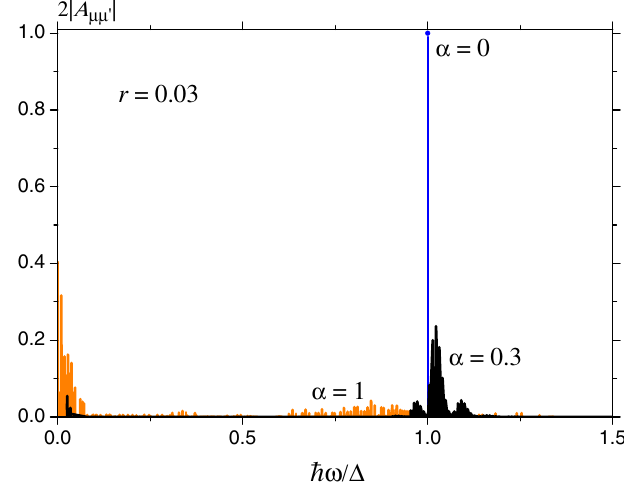
FIG. 4. Fourier spectrum of h (cid:1) and